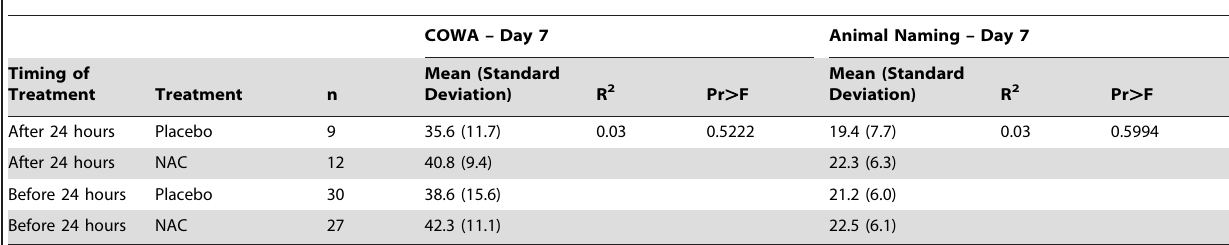
Table 9. Neuropsychological Tests: COWA and Animal Naming at Day